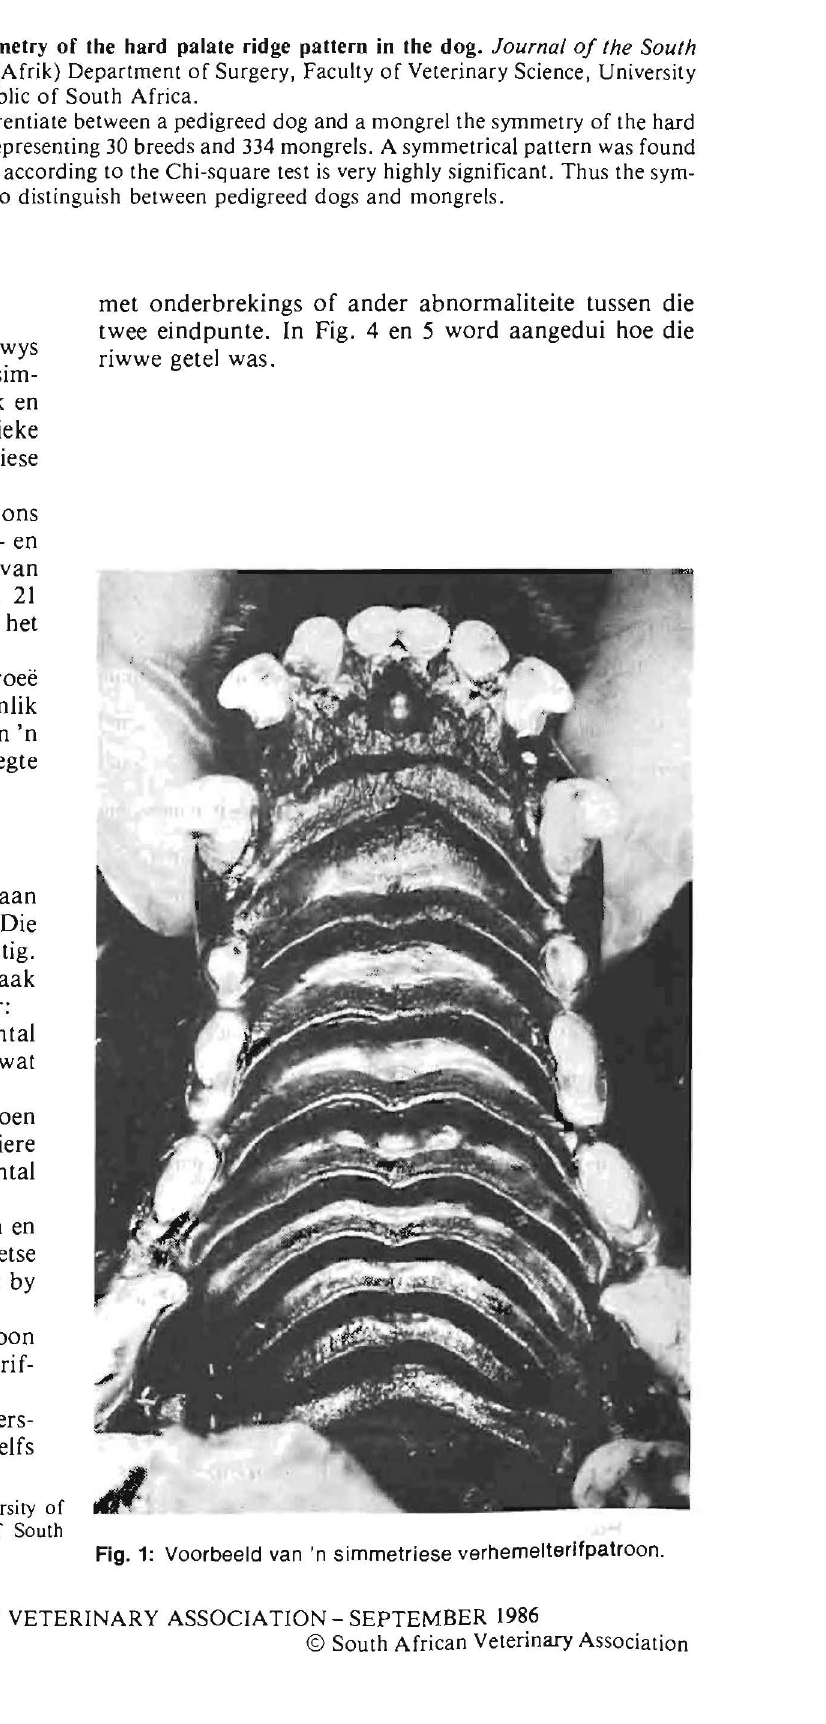
Fig. 1: Voorbeeld van 'n simmetriese